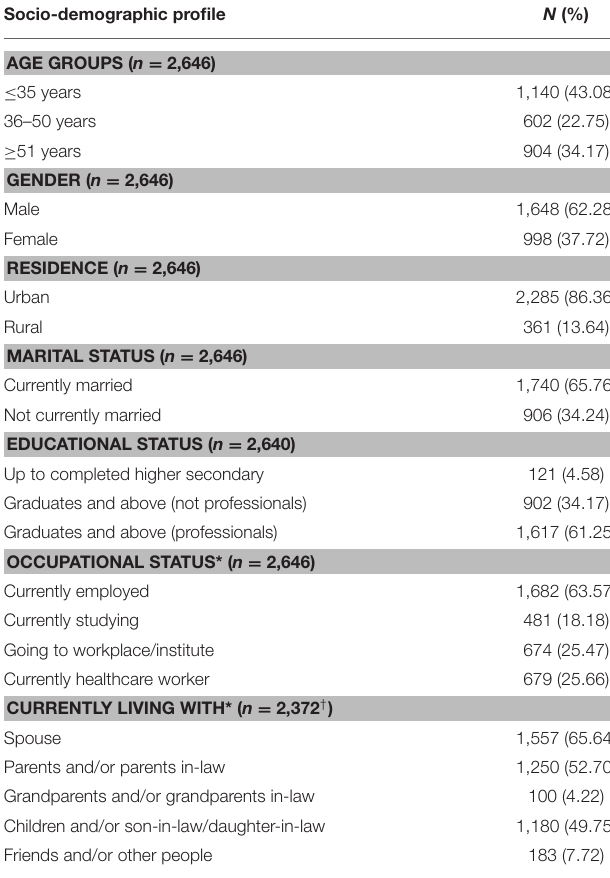
TABLE 1 | Socio-demographic profile of the